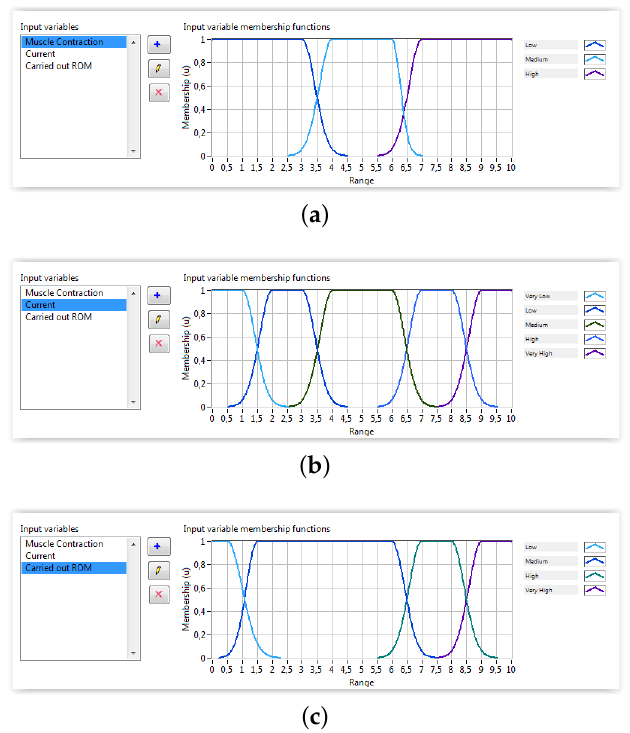
Figure 9. Second block inputs fuzzy membership functions: ( a ) muscle contraction; ( b ) current; ( c ) range of motion (RoM) achieved.